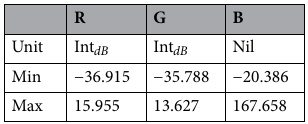
0 values in different bands.